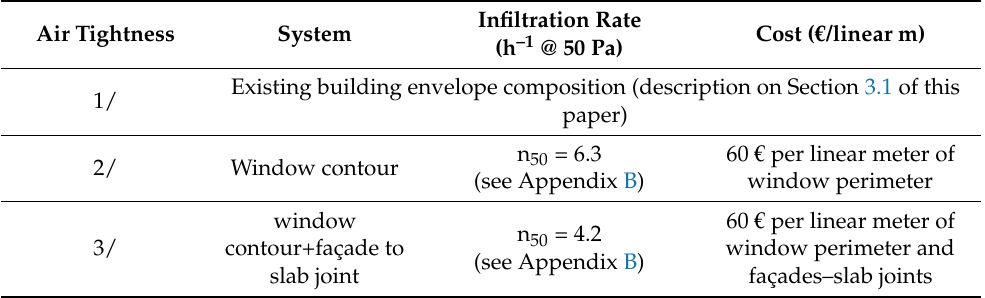
Table 4. Proposed renovation measures for